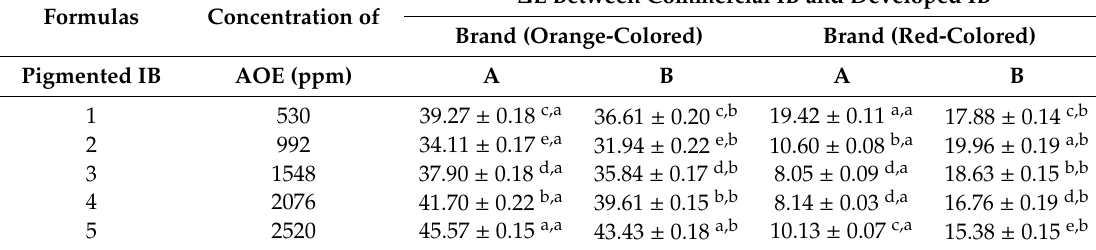
Table 3. Color di ff erences ( ∆ E) between red-color and orange-color commercial isotonic beverages (IB) with prototype pigmented isotonic beverages (PIBP) with di ff erent concentrations of astaxanthin oleoresin emulsions ( n =